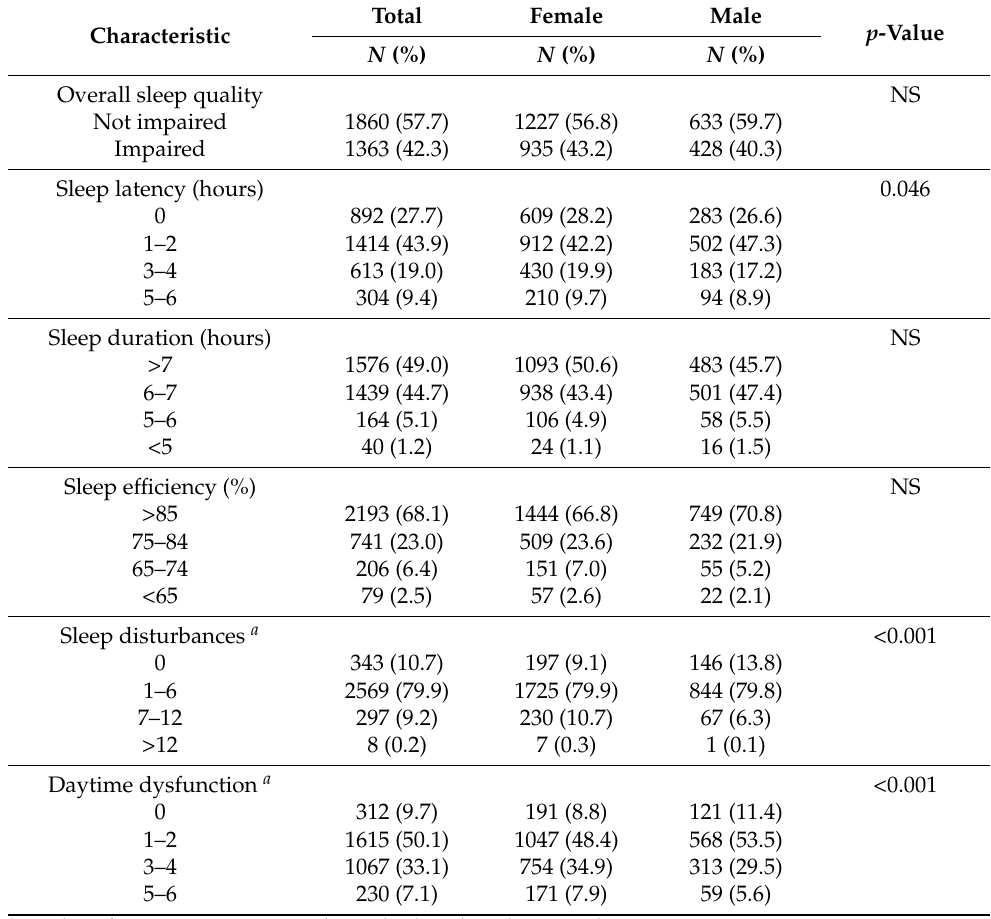
Table 4. Student sleep quality by sex.